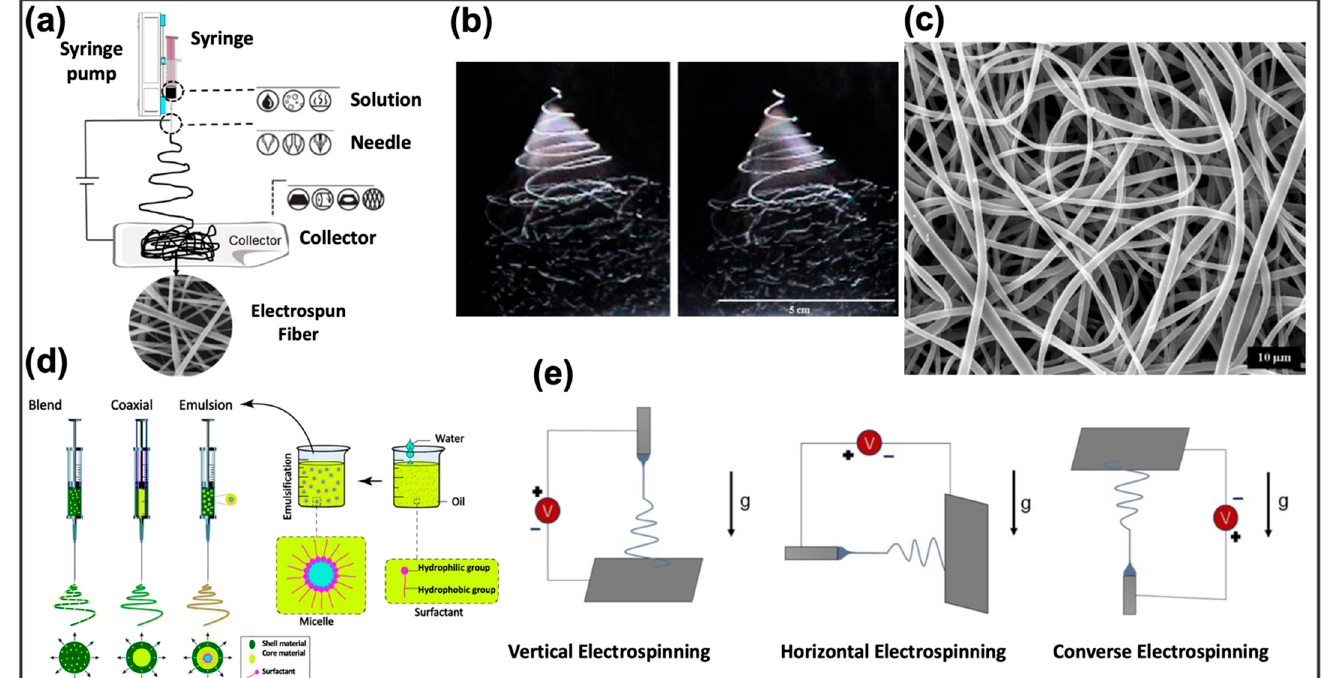
Figure 6. ( a ) Schematic representation of a classical electrospinning system. Reprinted from Fadil et al. [119], with permission under Polymers license. ( b ) Stroboscopic image of a polymeric jet, generated during electrospinning. Reprinted from [120] with permission under Polymer. ( c ) SEM image of the generated polymeric nanofibers. Reprinted from [120] with permission under Polymer. ( d ) Representation of the resulting nanofiber structures from different polymer feed solutions loaded for the electrospinning. Reprinted from Nikmaram et al. [121] with permission under RSC license. ( e ) Schematic representation of the impact of gravity on the resulting nanofibers in different orientations of the electrospinning system. Adapted from Nagam et al. [122] with permission under Fibers license.